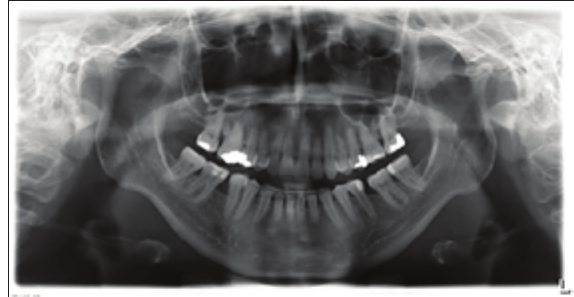
Figure 15. Panoramic radiograph of the patient after 10 years follow-